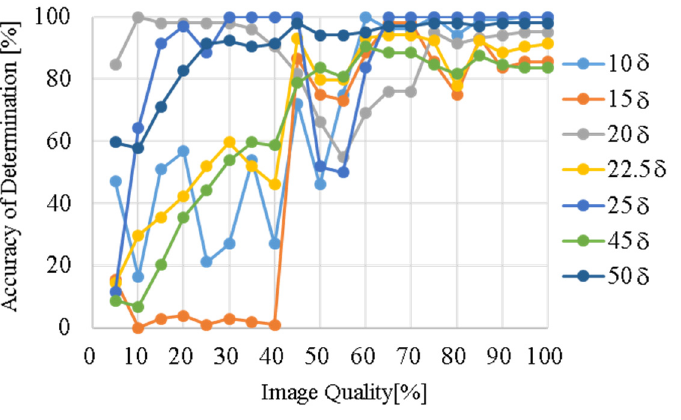
Figure 11. Dependence of the prediction accuracy on the image quality for seven classes of W0.9 δ .